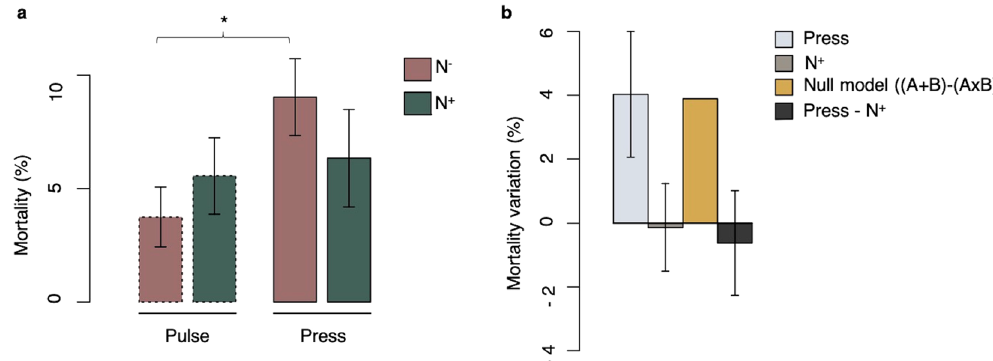
Figure 2. Effect of the interaction between salinity variation and nutrient enrichment on mortality levels in Mytilus sp. ( a ) Average mortality level (%) for salinity treatments (S) and nutrient concentrations (N) in Mytilus sp. Pair-wise contrasts showed a significant difference between pulses and freshwater presses with natural nutrient concentrations (p < 0.05) as identified by the asterisk. Histograms represent the mean value, and error bars correspond to standard errors. ( b ) Positive antagonistic interaction between freshwater presses and nutrient enrichment based on a null multiplicative model (yellow) ((S + N) − (S × N)). Single effects of stressors, compared to the least stressful conditions, are shown in light blue and gray and a combined effect is shown in dark gray. Error bars correspond to standard